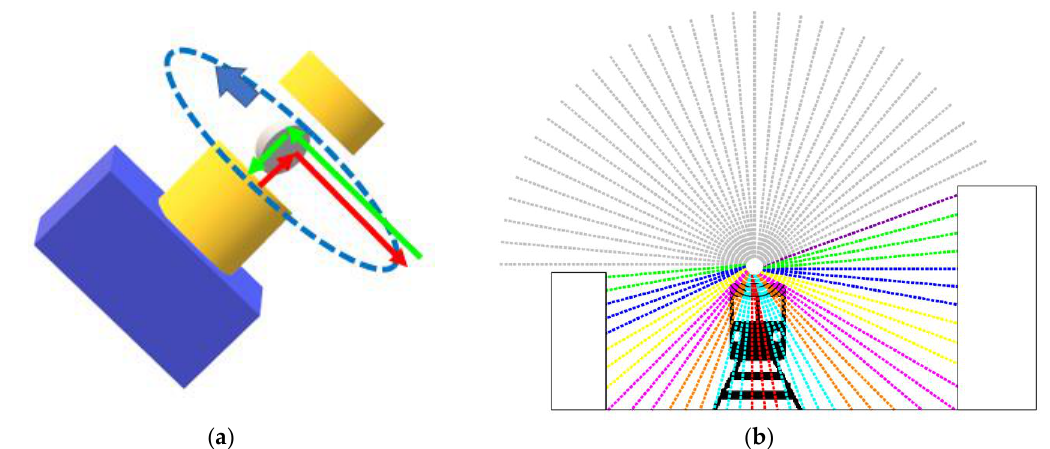
Figure 1. Laser sensor working principles schema: ( a ) Mirror rotation movement deflecting the emitted ( red ) and received ( green ) pulse; ( b ) Schematic representation of the reflected pulses creating a profile effect, coloured by the scan angle (grey pulses are not reflected to the sensor). The point cloud effect results from the train movement through consecutive cross-sections.